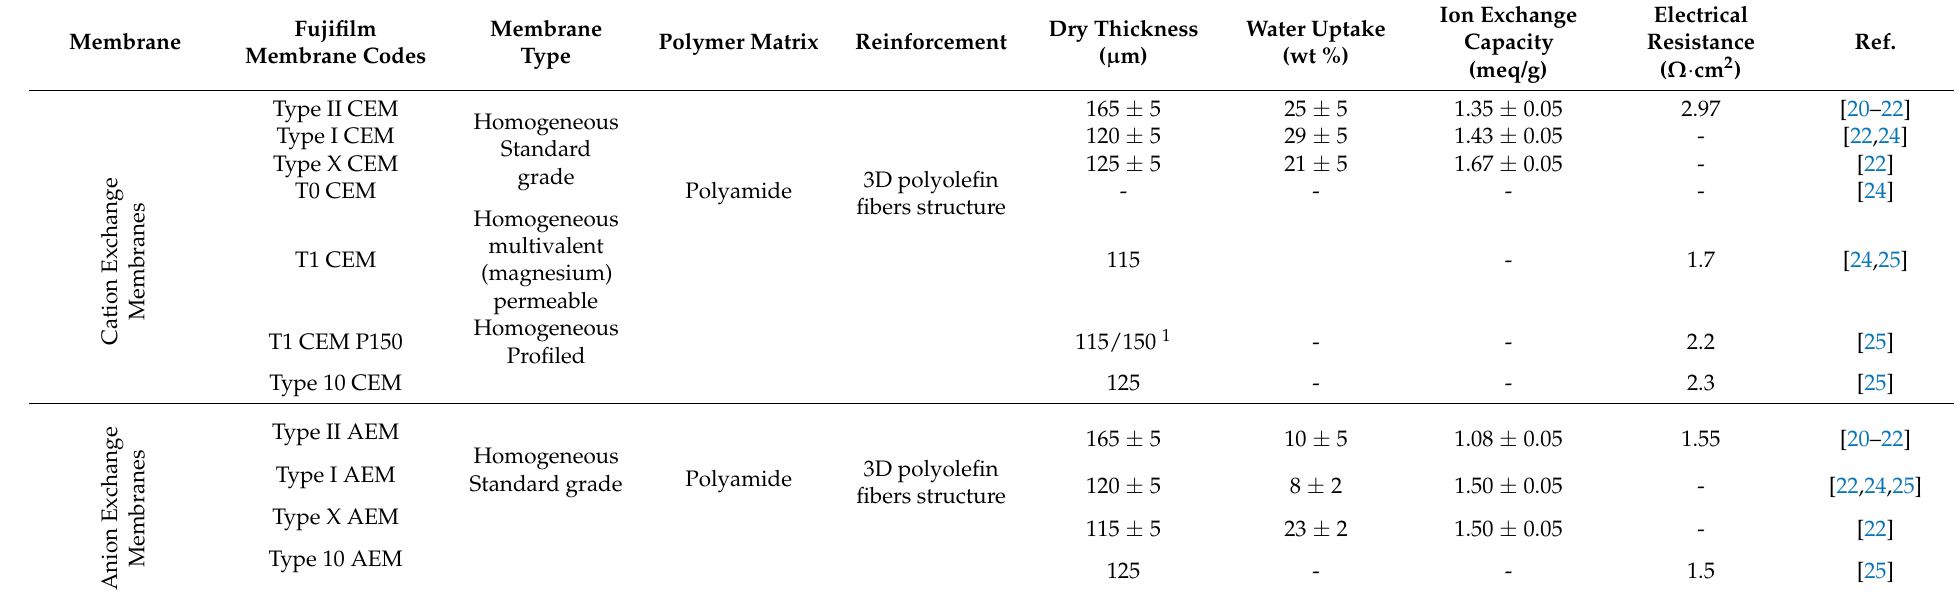
Table 1. Physicochemical properties of Fujifilm